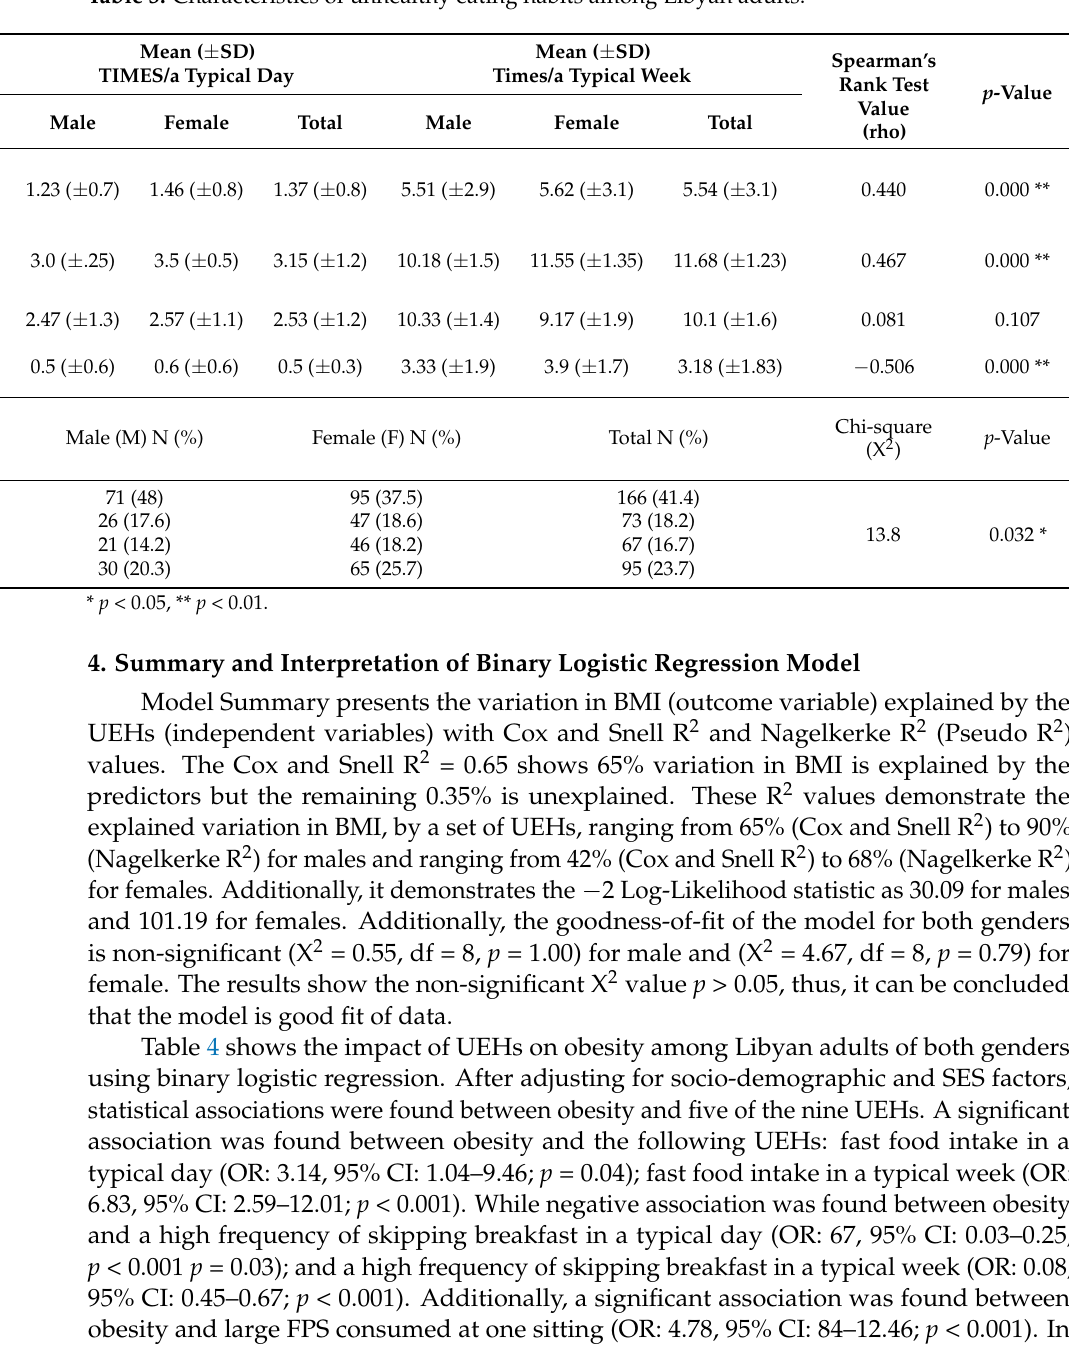
Table 3. Characteristics of unhealthy eating habits among Libyan